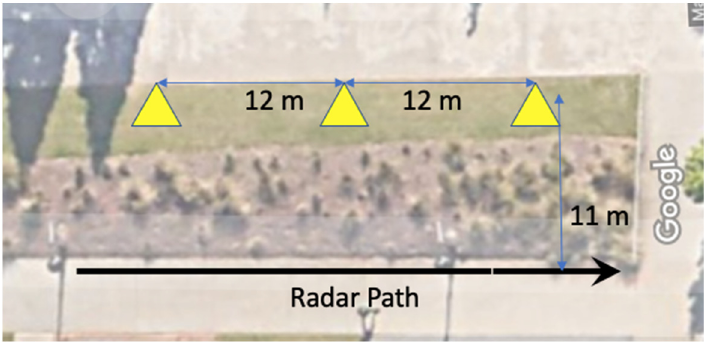
Figure 4. Diagram of the test setup of three corner reflectors and the radar synthetic aperture superimposed on a satellite photo of the location.